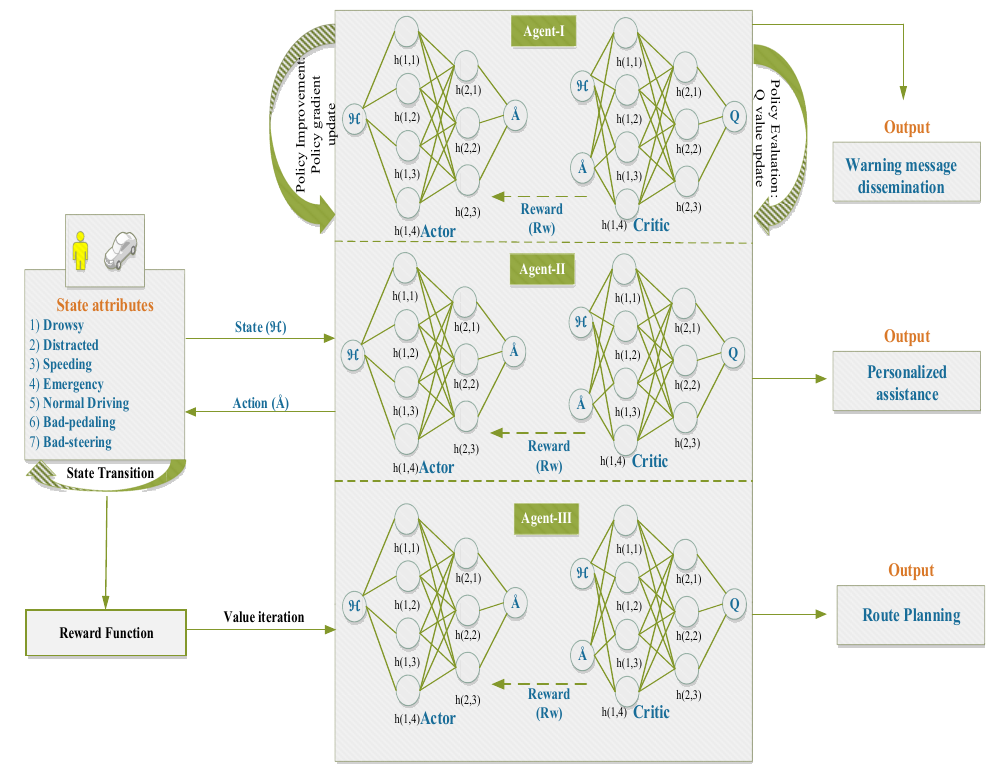
Appl. Sci. 2021 , 11 , 10462 19 of 31 Figure 5. working of TA-SAC algorithm. Figure 5. working of TA-SAC algorithm.